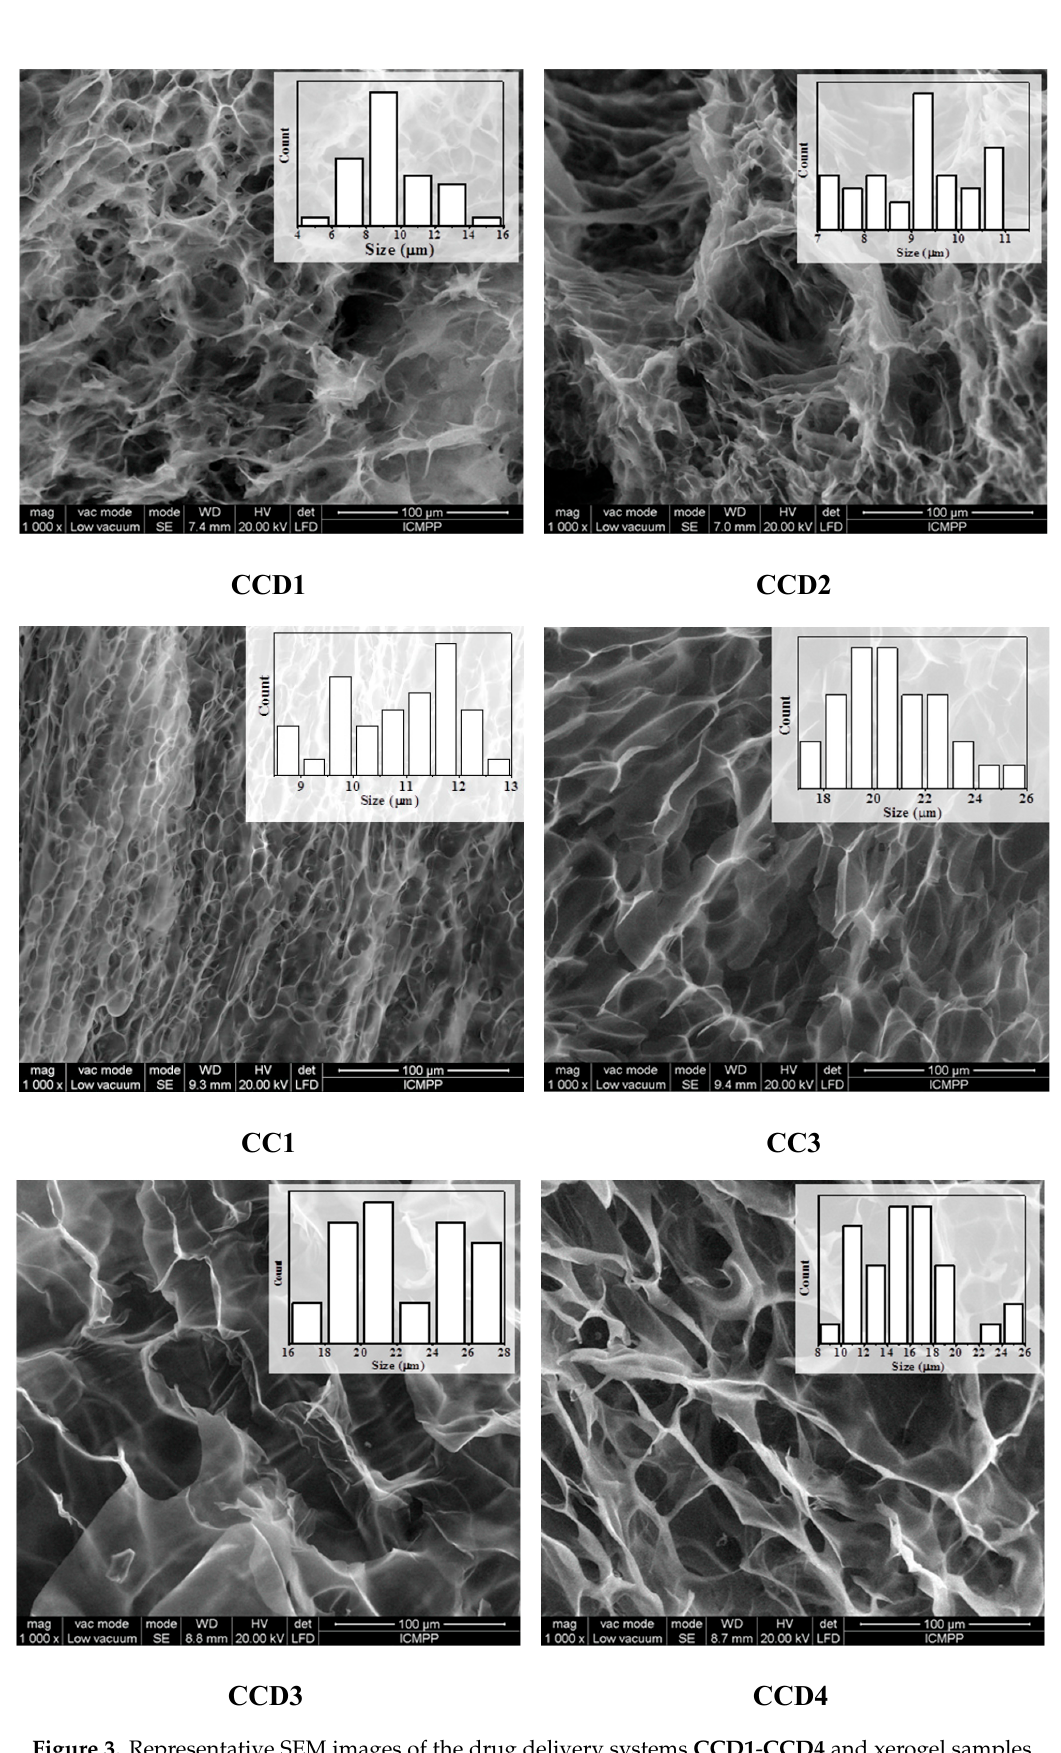
Figure 3. Representative SEM images of the drug delivery systems CCD1 - CCD4 and xerogel samples CC1 and CC3 . Table 2. Morphological parameters for the drug delivery systems and reference samples. Sample